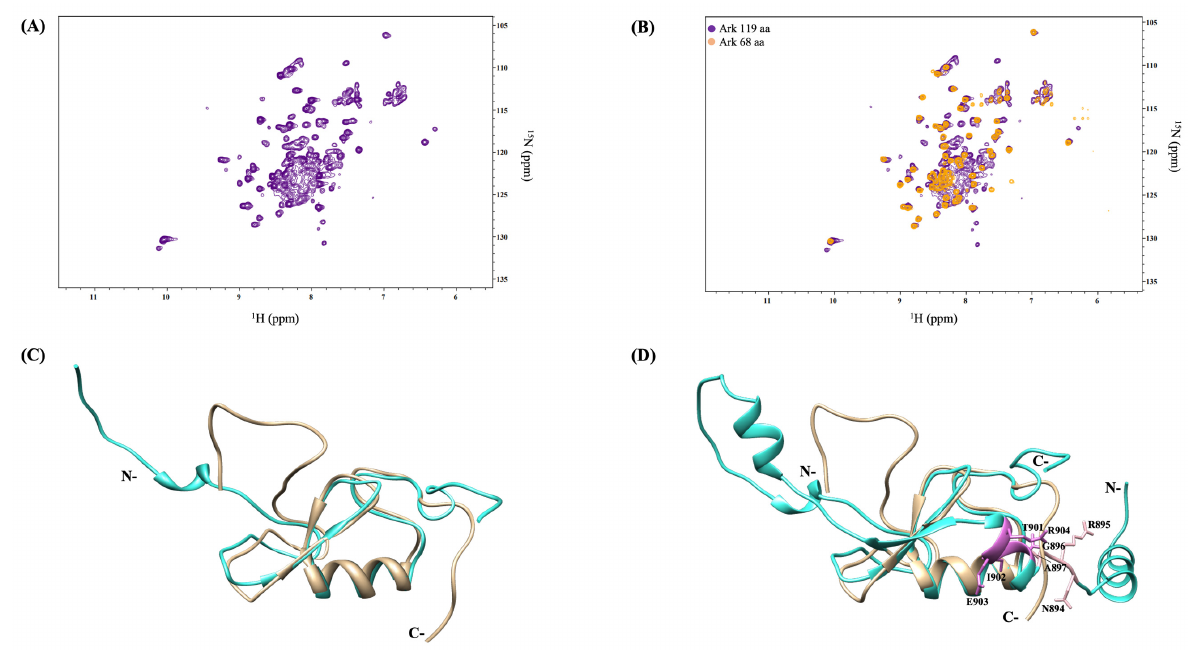
Figure 5. ( A ) 1 H- 15 N HSQC spectrum of Arkadia 119 aa polypeptide. ( B ) Superposition of the 1 H 15 N HSQC spectrum of Arkadia 68 aa with that of Arkadia 119 aa polypeptide. Most of the well dispersed resonances in the 1 H 15 N HSQC spectrum of Arkadia 119 aa overlap with those of the Arkadia 68 aa. ( C ) Overlay of the mean NMR model (colored in tan) and AlphaFold predicted structure (colored in turquoise) of Arkadia 68 aa. The superposition is almost perfect except for the disordered loop regions. ( D ) Overlay of the mean NMR model (colored in tan) and AlphaFold predicted structure (colored in turquoise) of Arkadia 119 aa. NRGA and TIER motifs are highlighted with pink and orchid, respectively.